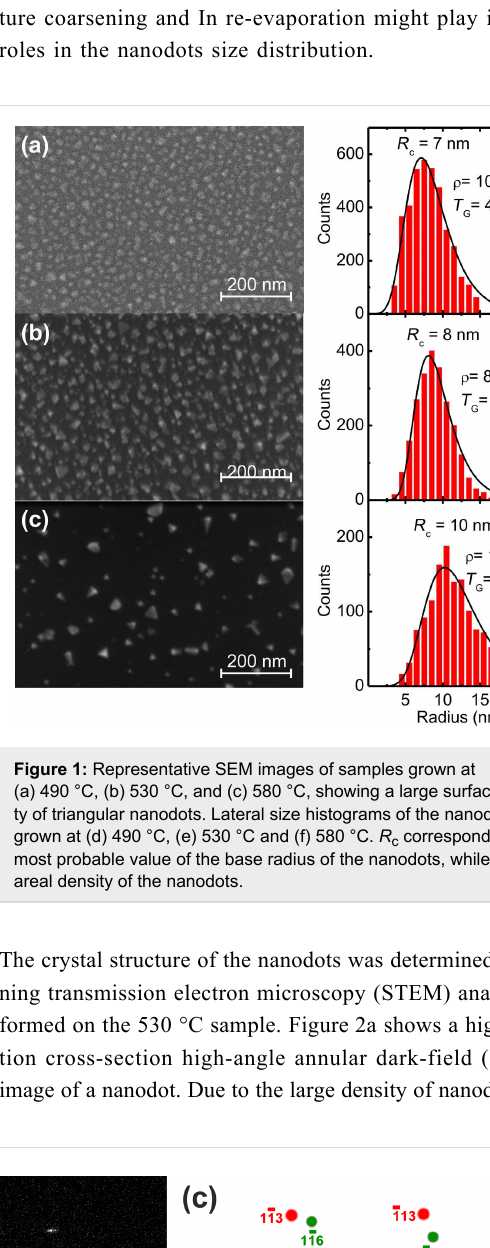
The crystal structure of the nanodots was determined by scan- ning transmission electron microscopy (STEM) analysis per- formed on the 530 °C sample. Figure 2a shows a high-resolu- tion cross-section high-angle annular dark-field (HAADF) image of a nanodot. Due to the large density of nanodots in